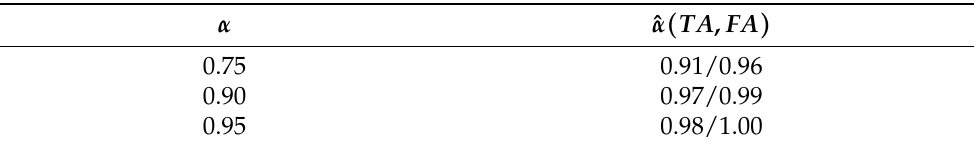
Table 3. Empirical confidence level ˆ α of the prediction interval method using the batch design as the validation set for different confidence levels α and for TA and